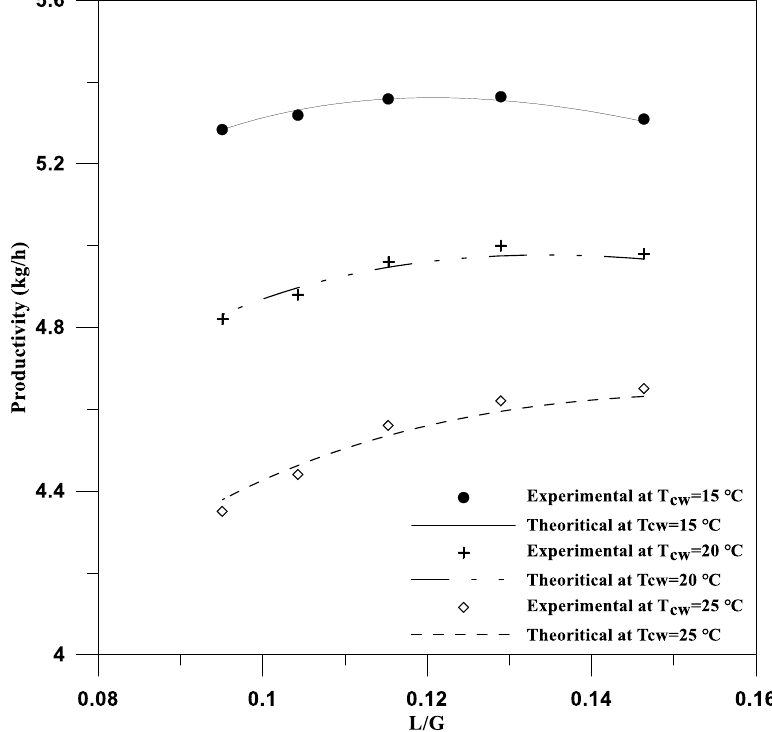
Figure 12. Productivity for the hybrid system at different inlet cooling water temperatures at the WCHE.